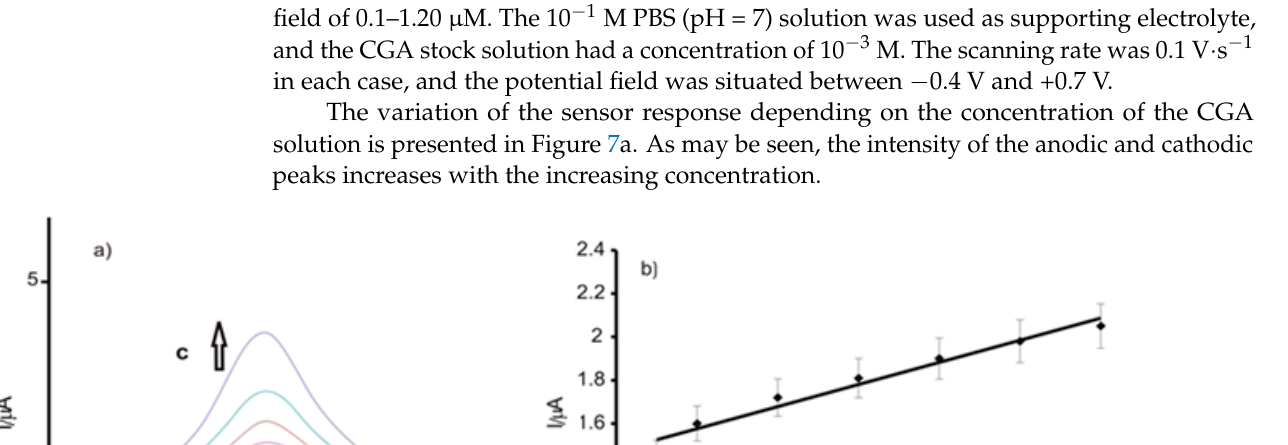
Table 5. LOD and LOQ values for CGA detection for each of the three sensors.